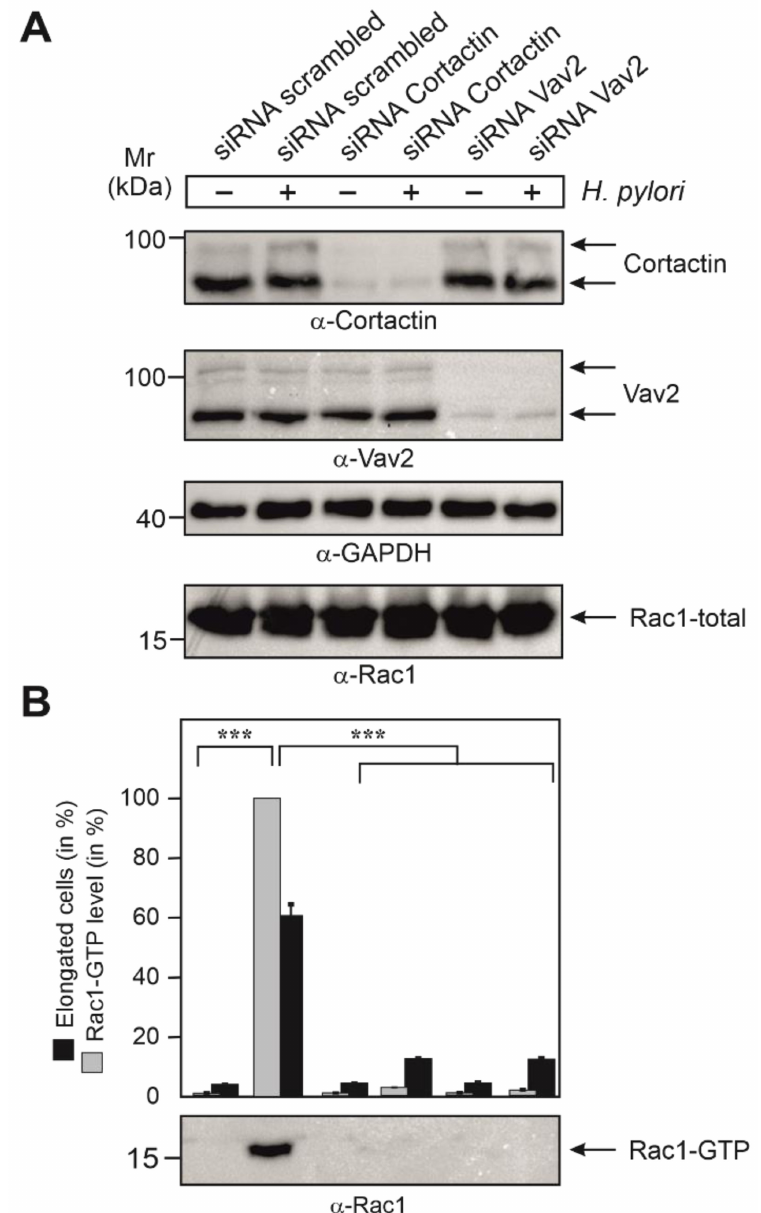
Figure 6. Control blots for the knockdown of cortactin and Vav2 by siRNAs and quantification of Rac1-GTP levels in AGS cells infected with H. pylori . ( A ) AGS cells were grown, treated with siRNAs and then infected with H. pylori wt, as described in Figure 7. The resulting cell lysates were probed with the indicated antibodies to demonstrate successful downregulation of cortactin and Vav2 expression, respectively, and equal protein loading in each lane. ( B ) A second set of samples, as shown in panel A, were subjected to Rac1-GTP pulldowns. The resulting α -Rac1 blot (bottom) was quantified by densitometric evaluation of the bands employing the luminescence imager. The sample showing the strongest Rac1 signal corresponds to 100% Rac1 activity in the respective blot. Inhibition of Rac1-GTP levels by knockdown of cortactin or Vav2 were quantified in three independent experiments. p -values of ≤ 0.001 (***) were considered to report on statistically significant